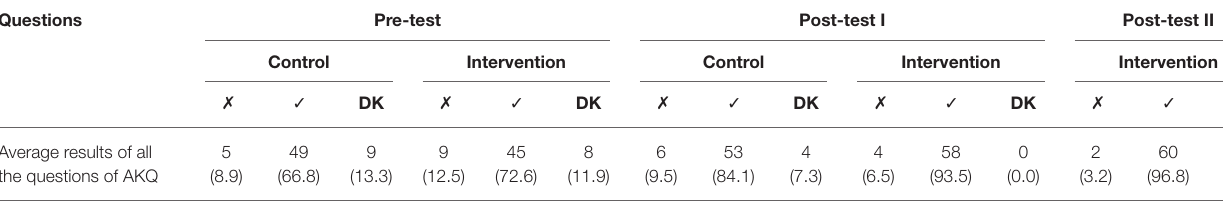
TABLE 7 | Asthma Knowledge Questionnaire (AKQ) summary of correct and incorrect